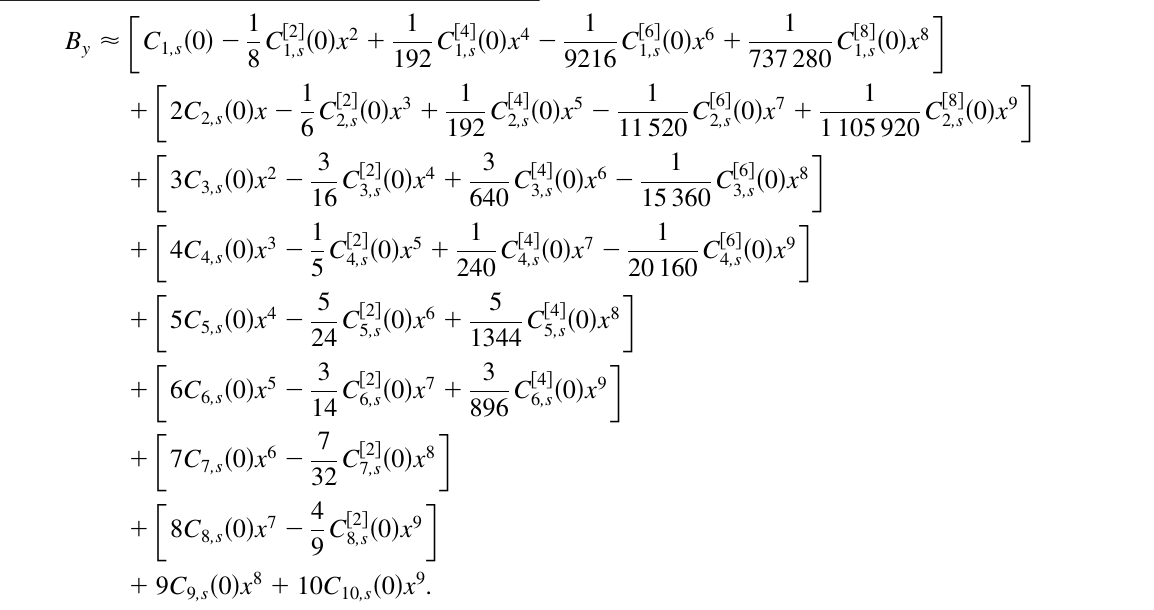
TABLE II. Contributions of multipole terms to B